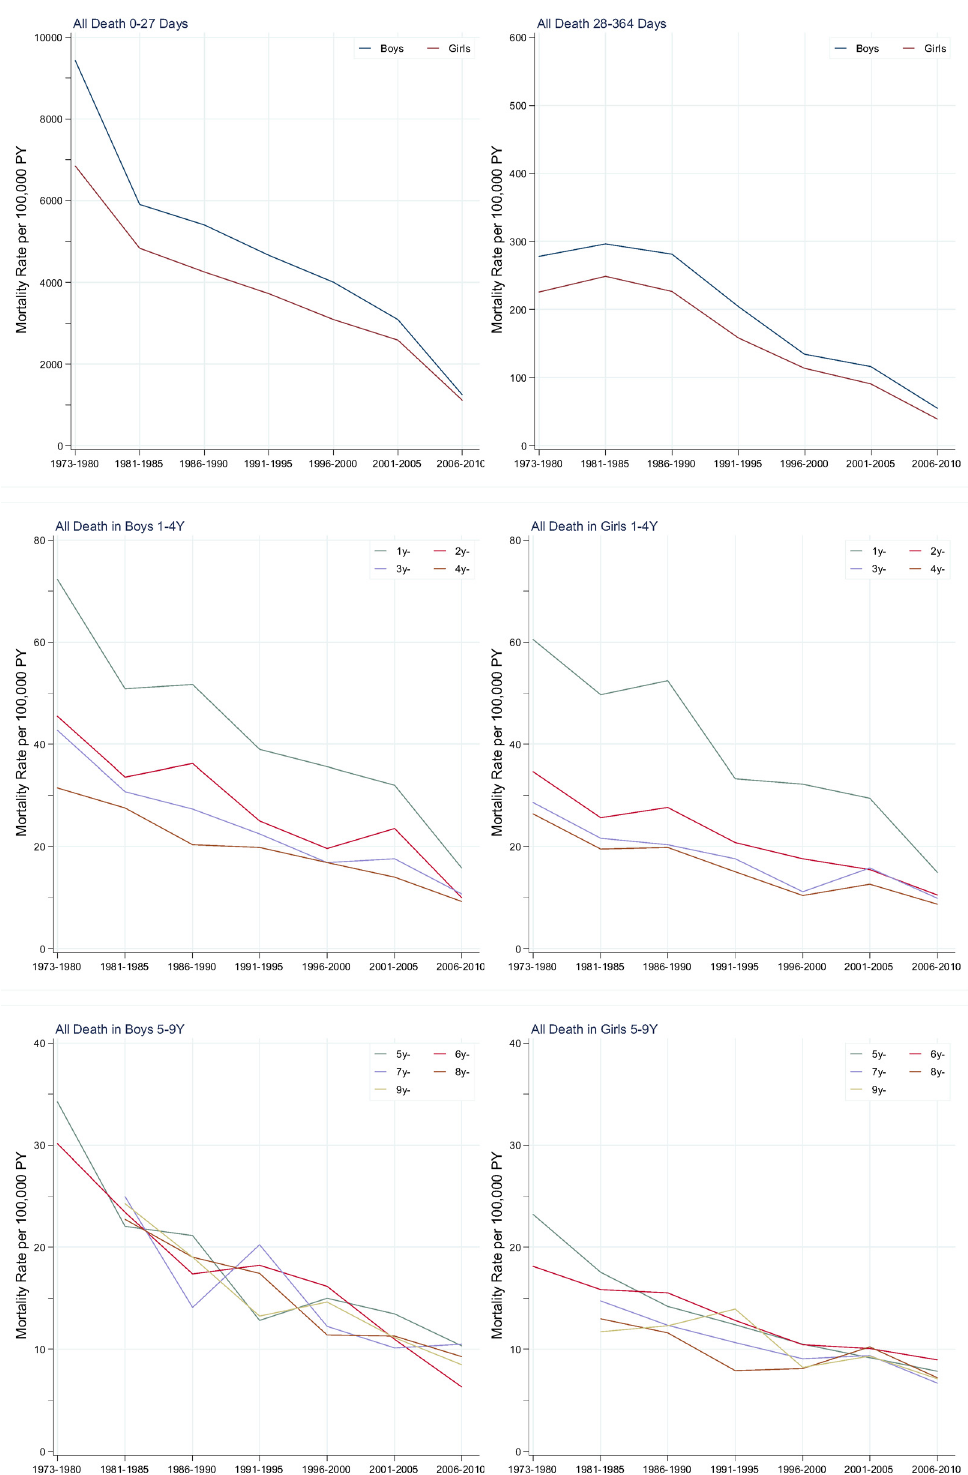
Fig 2. All-cause mortality rates in children aged 0 – 9 years over calendar periods and age.